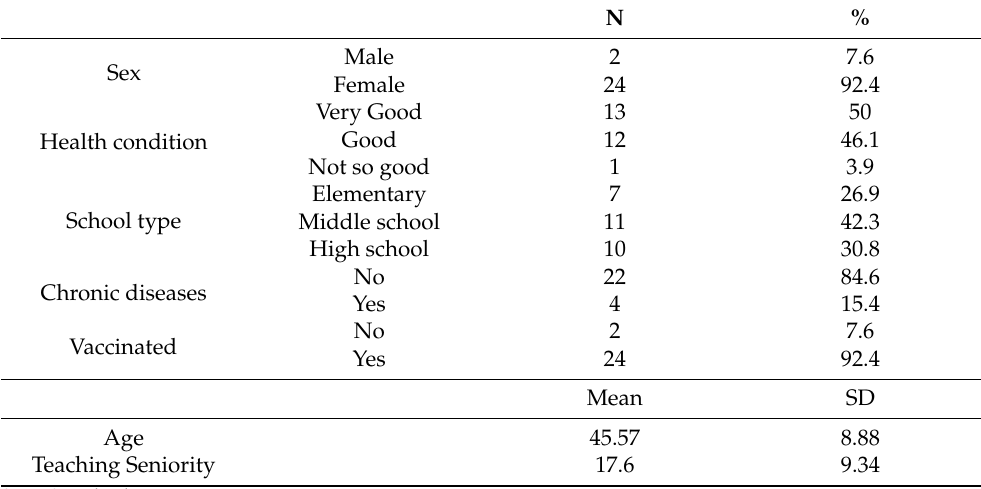
Table 2. Participants in the qualitative study (N =